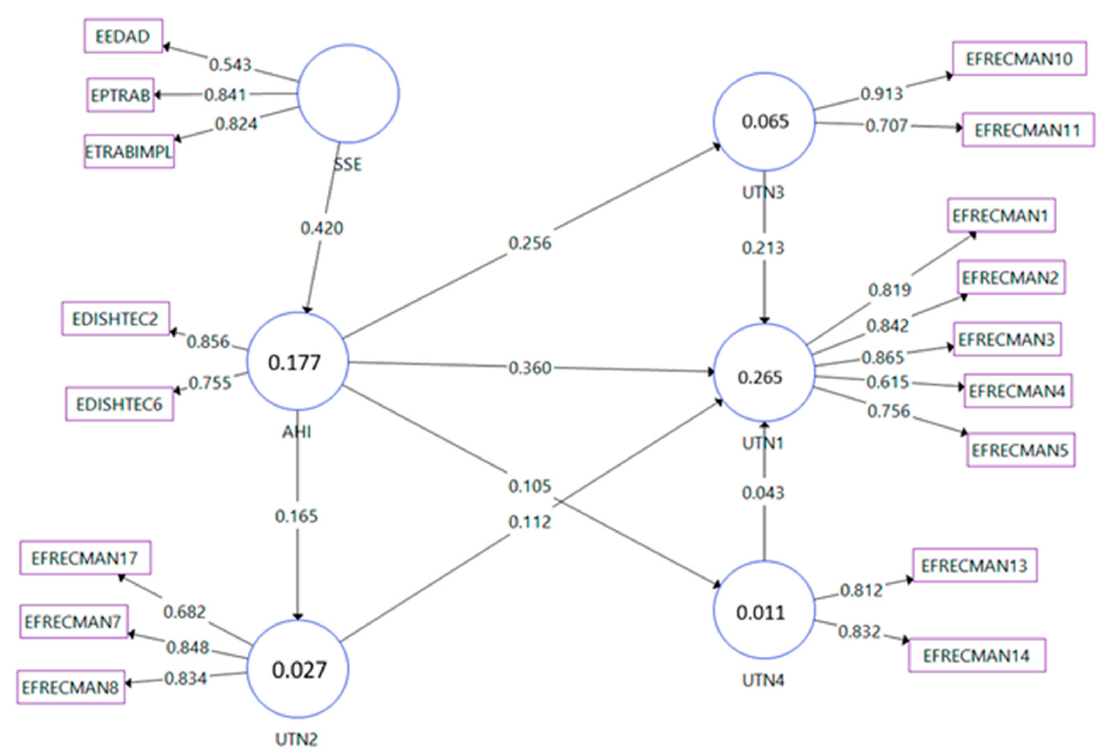
Figure 2. Structural model. Source: Own elaboration.